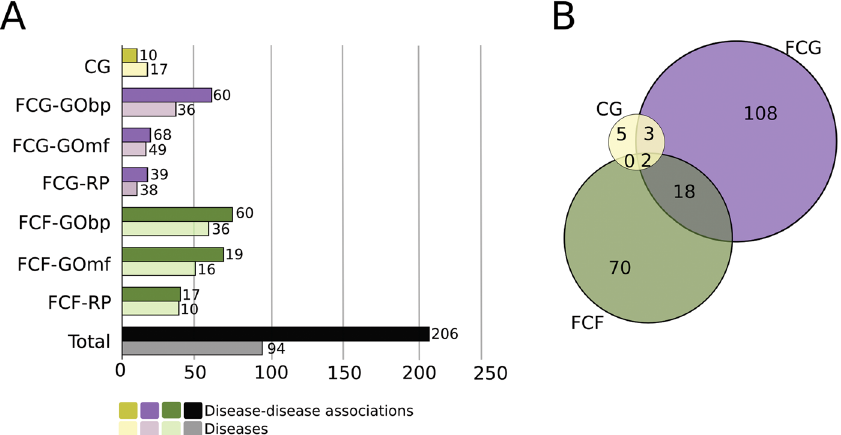
Figure 2. Number of disease-disease associations according to the strict criterion. ( A ) Light bars represent the number of diseases considered in each measure. Dark bars represent the number of significantly associated disease pairs identified according to each measure (CG in yellow colour, FCG in purple and FCF in green) using the strict multiple hypothesis testing criterion. The number of disease pairs linked by at least one of the measures are given in black, showing the total number of associations obtained. ( B ) Venn diagram of the sets of associations found by the CG, FCG and FCG measures and their